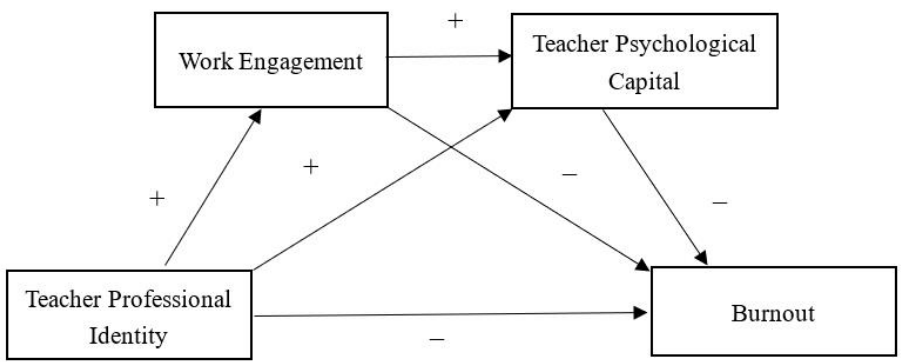
Figure 1. Hypothesized